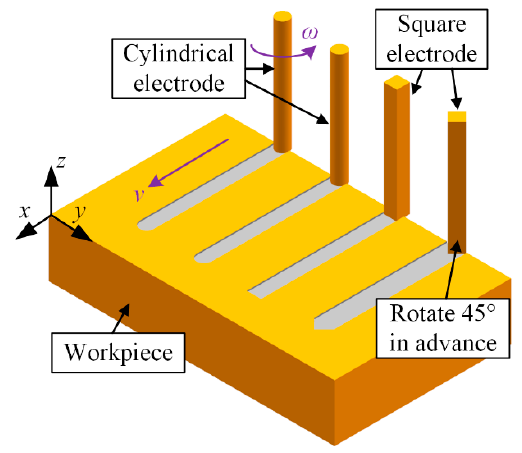
Figure 14. Schematic diagram of the machining process. Table 3. Machining parameters for Exp. 1.